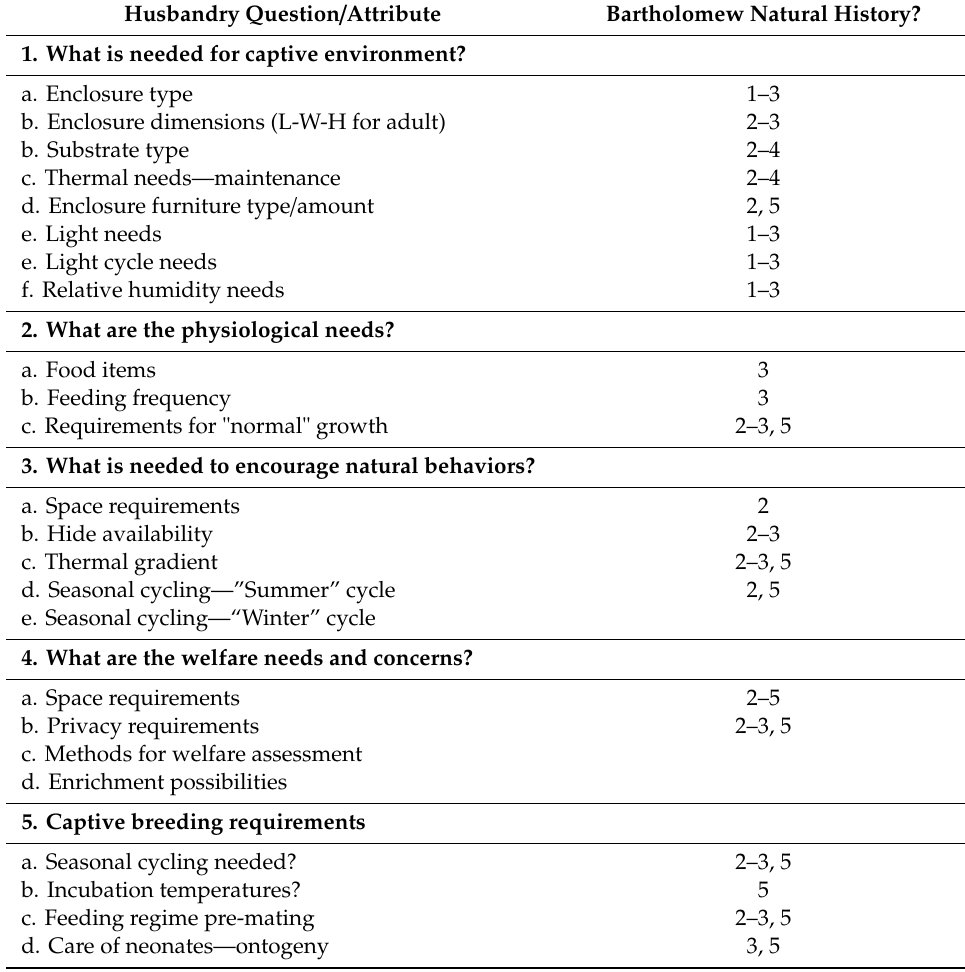
Table 2. Herpetocultural husbandry questions / attributes needed to ensure amphibians and reptiles exist / survive in human care, and the associated Bartholomew natural history questions that lead to husbandry